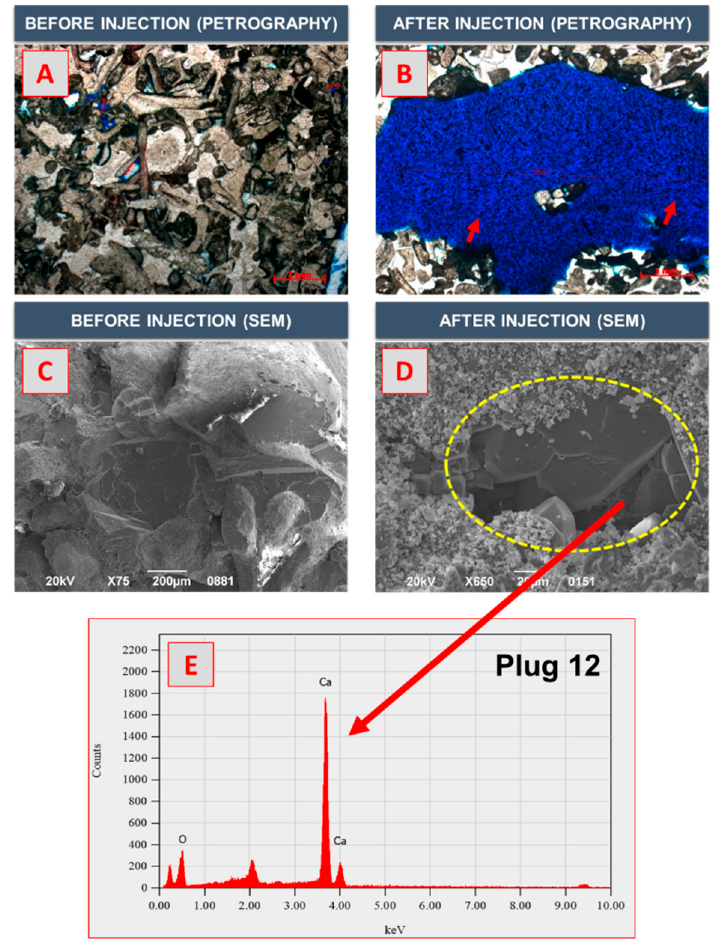
Figure 8. Results of SEM–EDX and thin-section analyses of Plug 12.